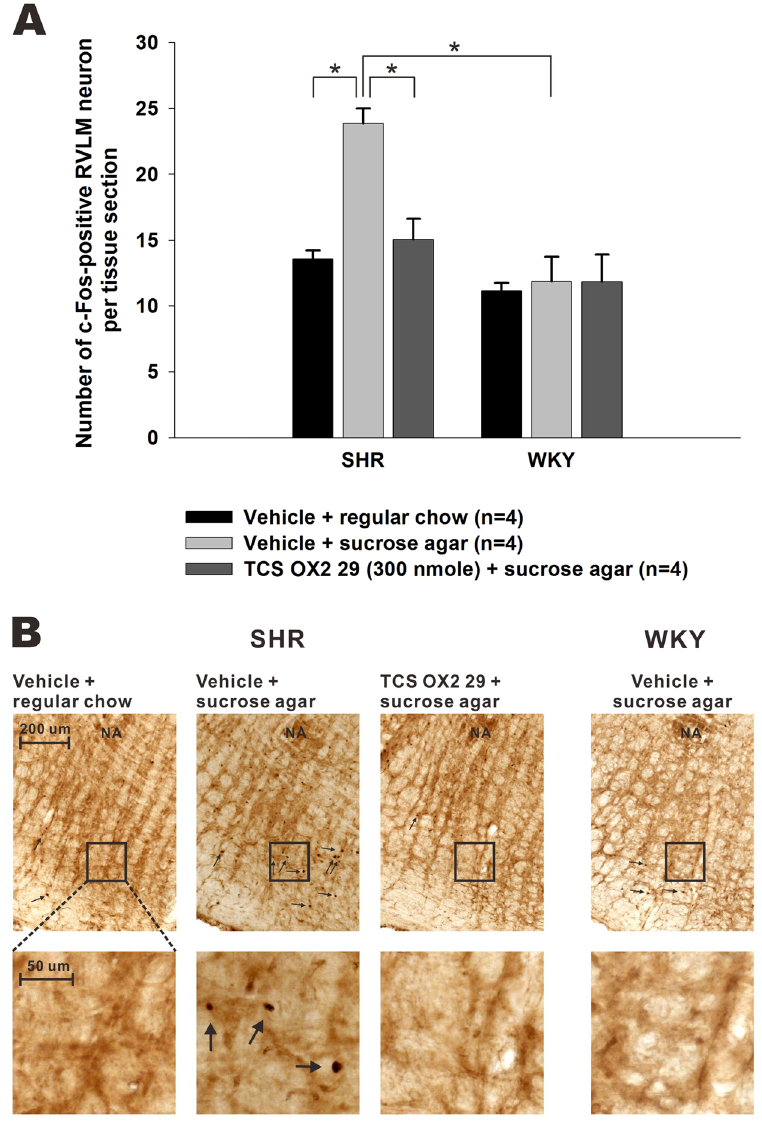
Figure 5. Comparisons of c-Fos expressions in the rostral ventrolateral medulla (RVLM) following food consumption in spontaneously hypertensive rats (SHR) and Wistar-Kyoto rats (WKY) and the roles of the orexin 2 receptor (OX2R). Panel A shows the numbers of c-Fos-immunoreactive RVLM neurons per brainstem slice in SHR and WKY of different treatment groups as indicated. TCS-OX2-29 (300 nmol) or vehicle was intracerebroventricularly applied 30 min before food was presented. Values are the mean ± SEM. A star “ * ” indicates a significant difference between the indicated groups, as determined with a one-factor ANOVA followed by Duncan’s multiple-range test. Panel B demonstrates photomicrographs of c-Fos-immunoreactivity in the RVLM from SHR that had received treatments as indicated. Arrows indicate cells with c-Fos-